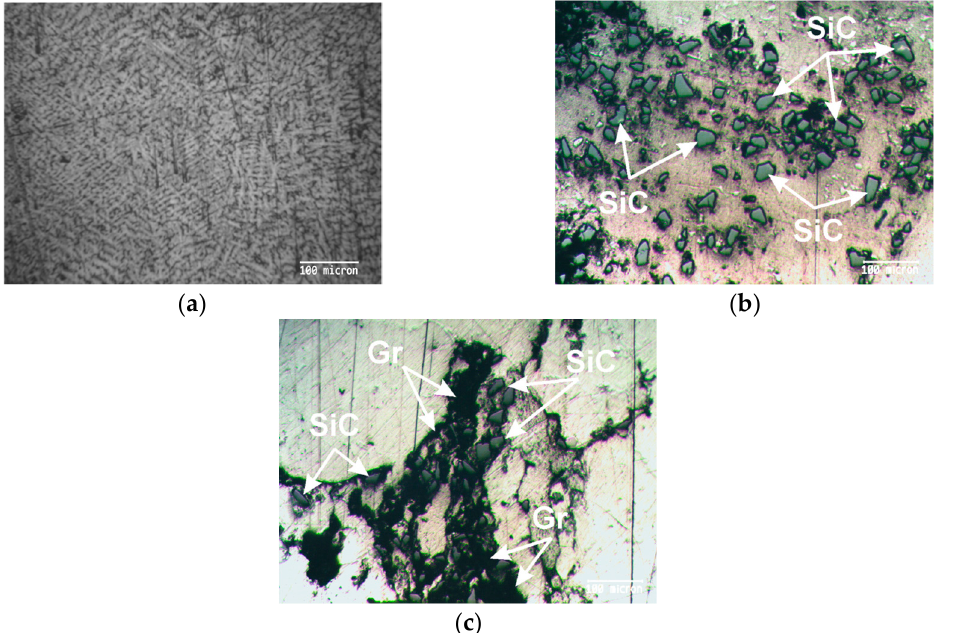
Figure 1. The microstructure of the tested materials: ( a ) ZA27 alloy; ( b ) ZA27/5%SiC composite; ( c ) ZA27/5% SiC/3%Gr hybrid composite.